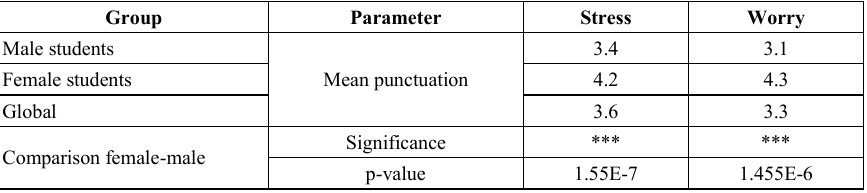
Table 6. Psychological indicators: gender gap in the